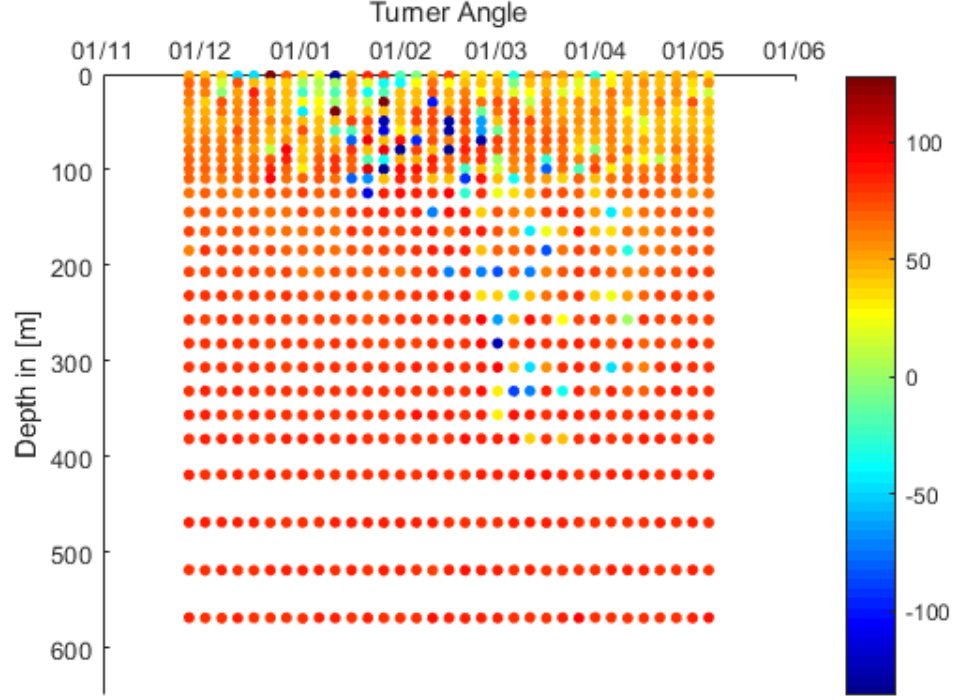
Figure 13. The Turner angle ( ◦ ) of float WMO 6900098 shows the contribution of salinity and temperature gradients to the density gradient.